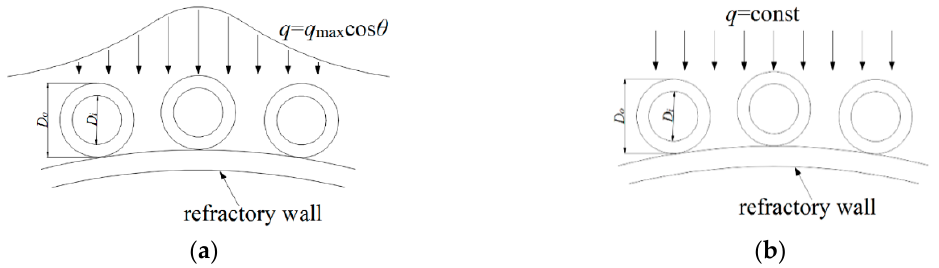
Figure 3. The heat flux conditions: ( a ) nonuniform heat flux (NHF) ( b ) uniform heat flux